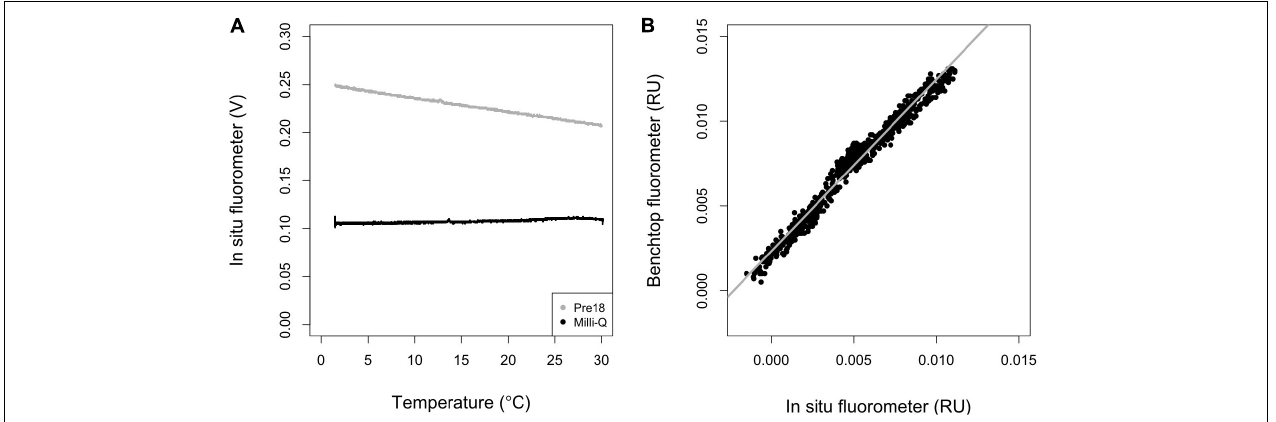
FIGURE 2 | (A) Temperature dependence of the in situ fluorometer for Multiparameteric Standard Seawater, lot Pre18 (gray) and MilliQ-water (black), and (B) the relationship between the results obtained using a benchtop fluorometer and the outputs of the in situ fluorometer which were first corrected for temperature dependence and then converted to RU using the conversion factor [Eq. (13)]. In (B) , the gray line represents the regression line ( R 2 = 0.97, n = 769, p < 0.001).